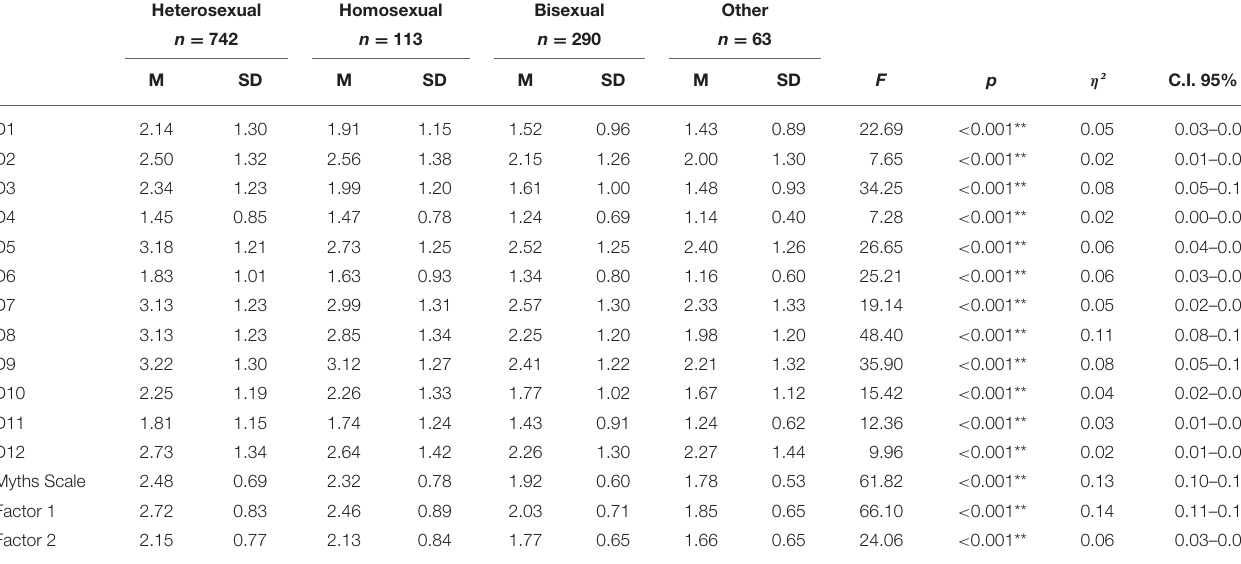
TABLE 3 | Descriptive and comparative analysis, according to sexual orientation, of the Scale of Myths of Romantic